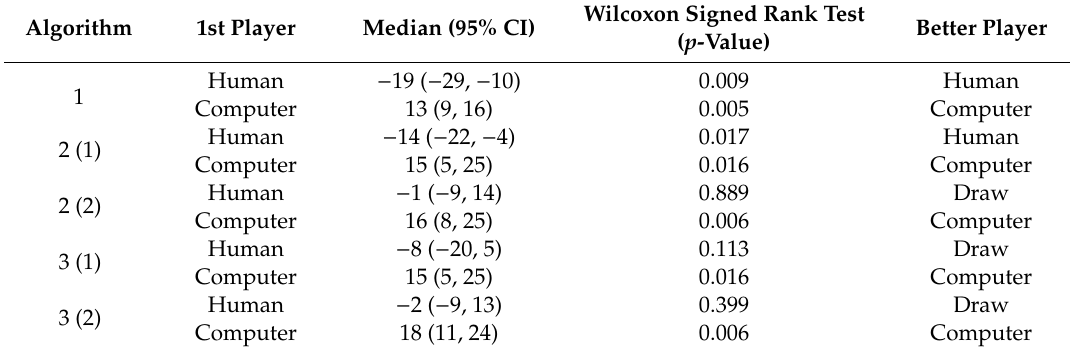
Table 3. Statistical tests on selected data from Table 1.